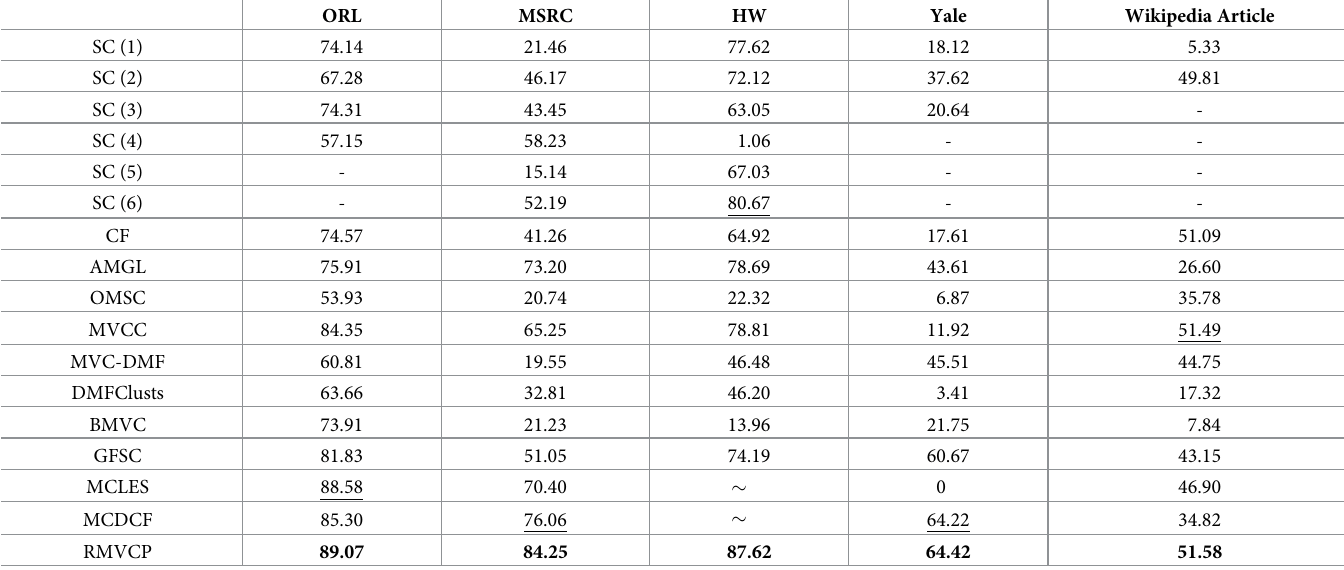
Table 3. Comparison of algorithms on five datasets for NMI.